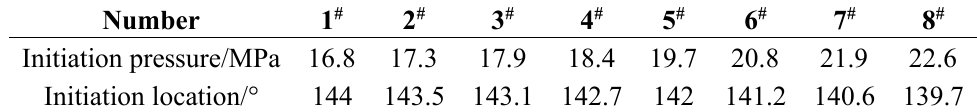
Table 4. Theoretical initiation parameters of Nos. 1 # –8 #